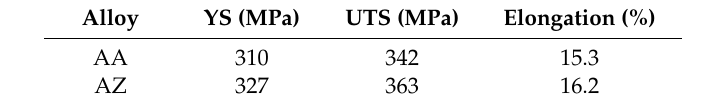
Figure 7. Tensile test results of alloy AA and AZ under peak aged conditions at 170 °C. Table 5. Mechanical properties of alloy AA and AZ under peak aged conditions at 170 °C